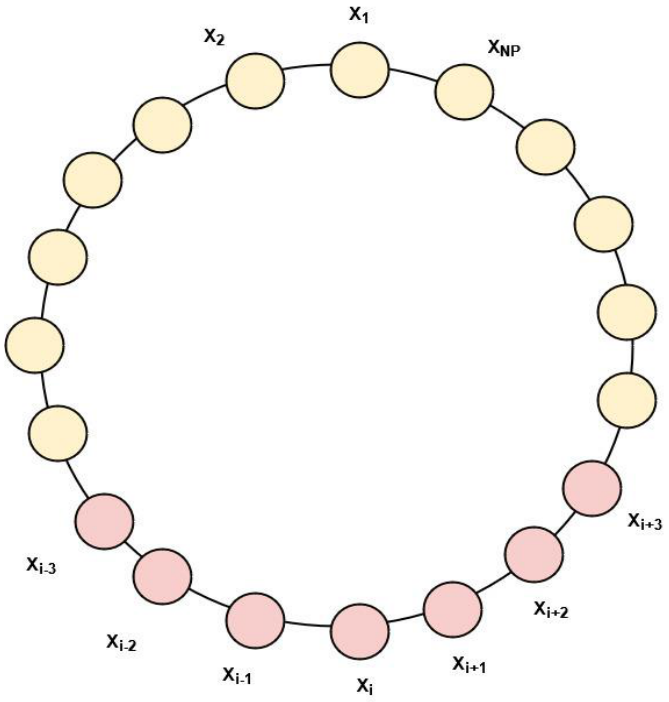
Figure 1. Neighborhood ring topology of radius 3.